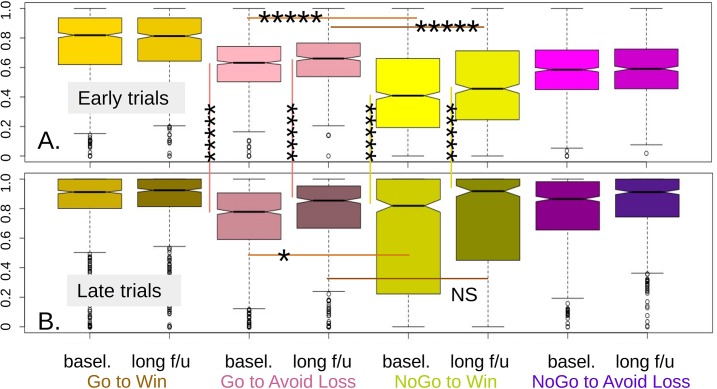
Raw performance in the all conditions.The middle two quartiles are in solid color, with the ‘avoid loss’ conditions in pink/purple and ‘win’ in gold/yellow. Just non-overlapping notches represent p = 0.05 for the uncorrected difference between two medians. One star denotes p <0.05 corrected for 8 comparisons; Five stars denote pcor < 1e-10. Long follow-up is shown next to baseline. A. Performance weighted towards early trials, the weighing decreasing linearly to 0 for the middle of the task. No-Go to win (NG2W) showed median success rate slightly below chance, in line with the literature. B. Late trials. Performance reaches maximum for at least a quarter of participants in both appetitive conditions, but a quarter (long follow-up) or more (baseline) participants still perform below chance in NG2W. Long follow-up shows better performance than baseline in all except the easy Go-to-Win (G2W) conditions.